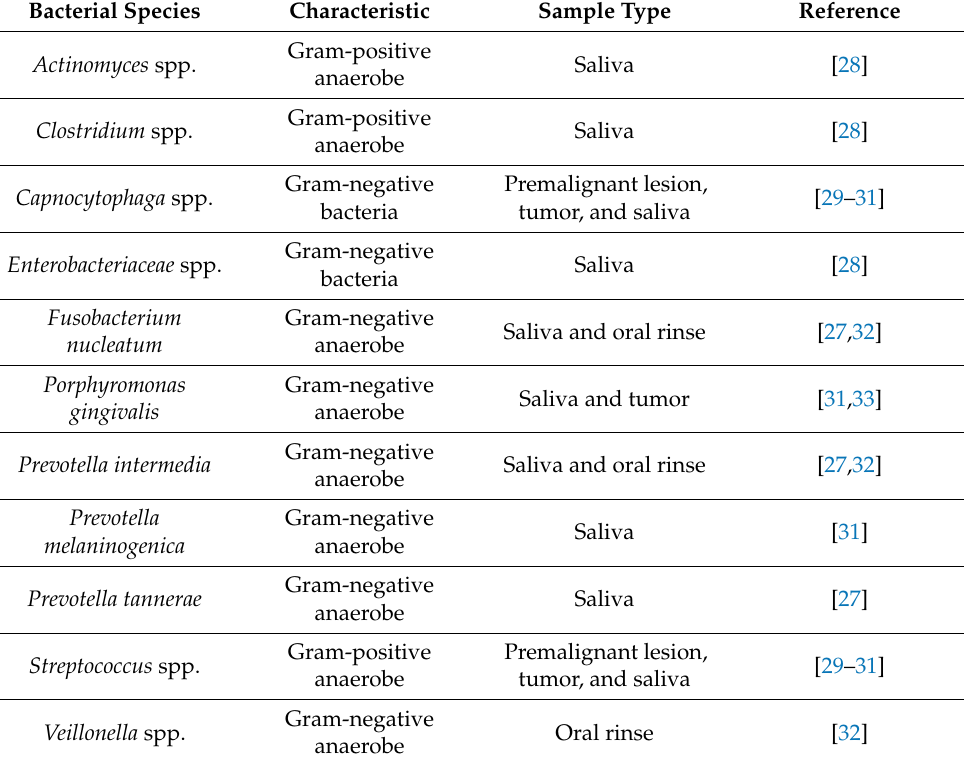
Table 1. Examples of bacterial species associated with oral cancer development. Bacterial